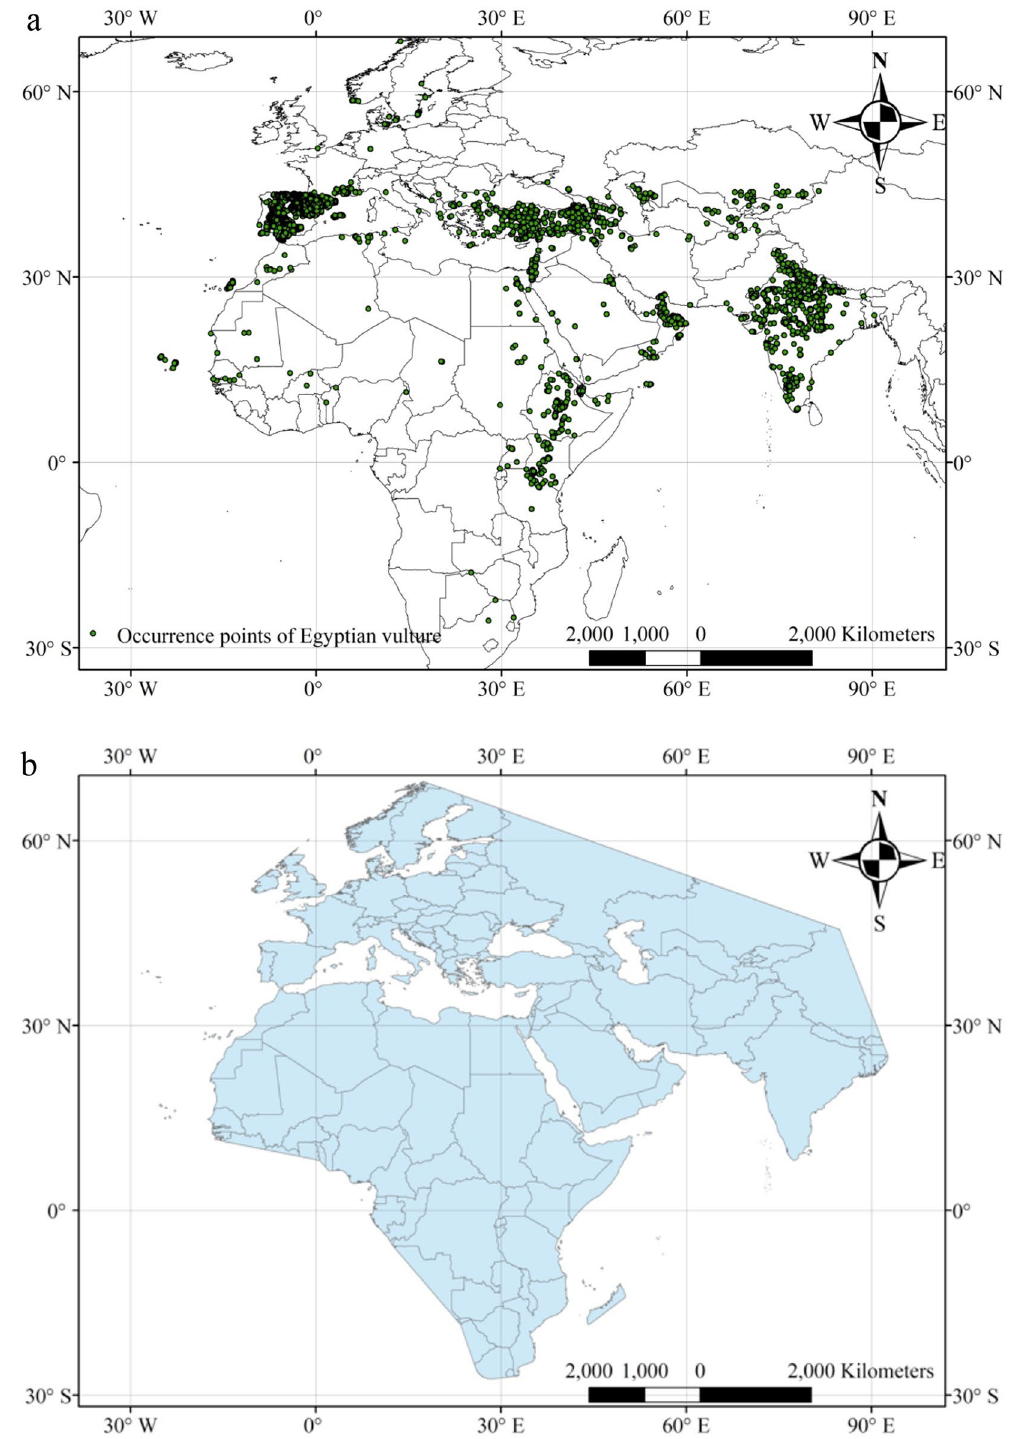
Figure 1. ( a ) Global location of Egyptian vulture occurrence points used in this study (n = 15,598). These data included observations from 2000–2018 with an expected < 1 km uncertainty in their locations. ( b ) These occurrence data were used to create a search area for the likely global species range by joining the outermost points; it is within this area that the MaxEnt modelling was used to create the species distribution map for most suitable